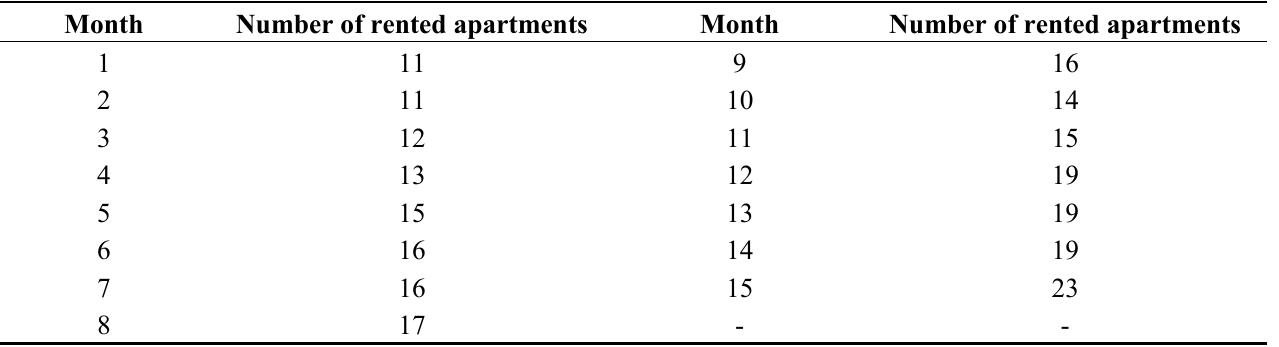
Table 4. Building’s occupancy level (number of rented apartments) during the first 15 months. The first three months were not used for the analysis of the measurement data. Total number of apartments in the building is 32.